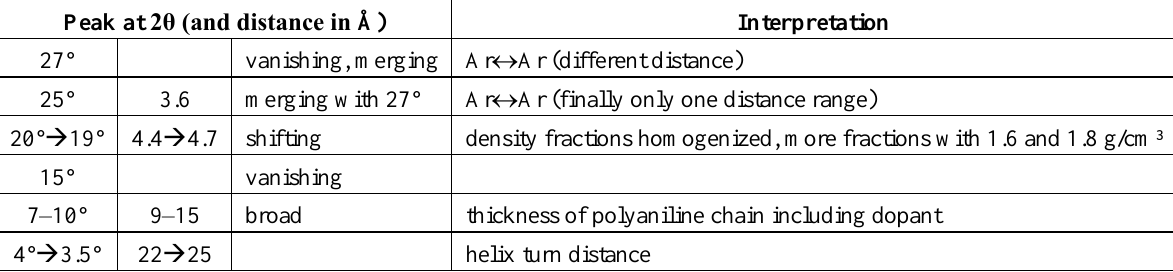
Table 1. Summary of peaks and their changes in x-ray diffraction. Peak at 2θ (and distance in